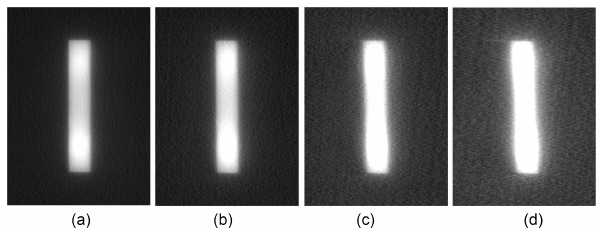
different speeds.